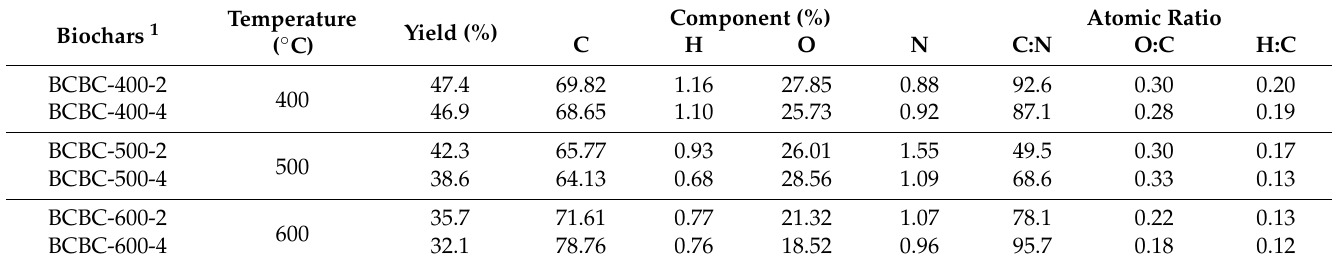
Table 1. The yields and element contents of biochars produced at different conditions.